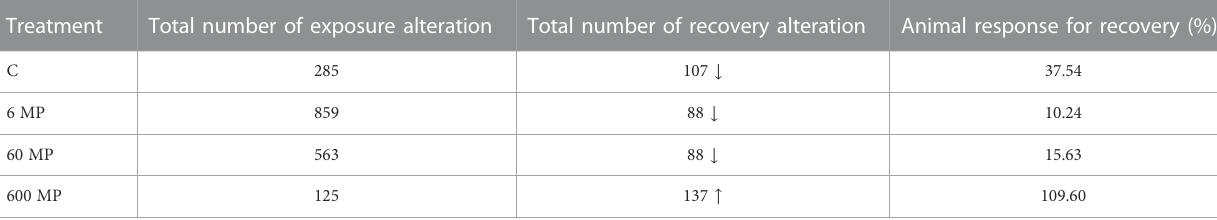
TABLE 2 Response of the animals after 15 days of